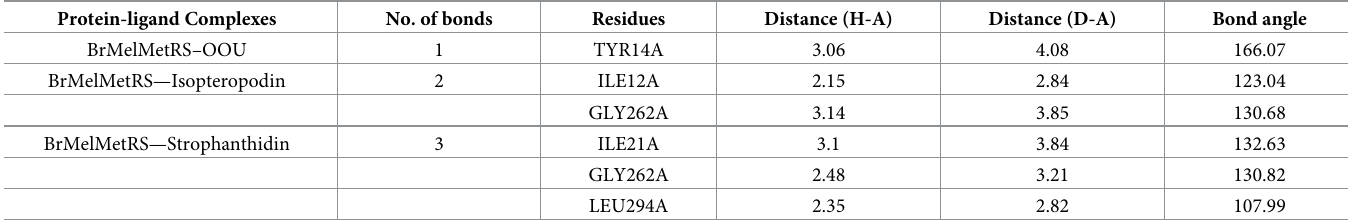
Table 4. Analysis of Hydrogen bond interactions between target and ligands. Protein-ligand Complexes